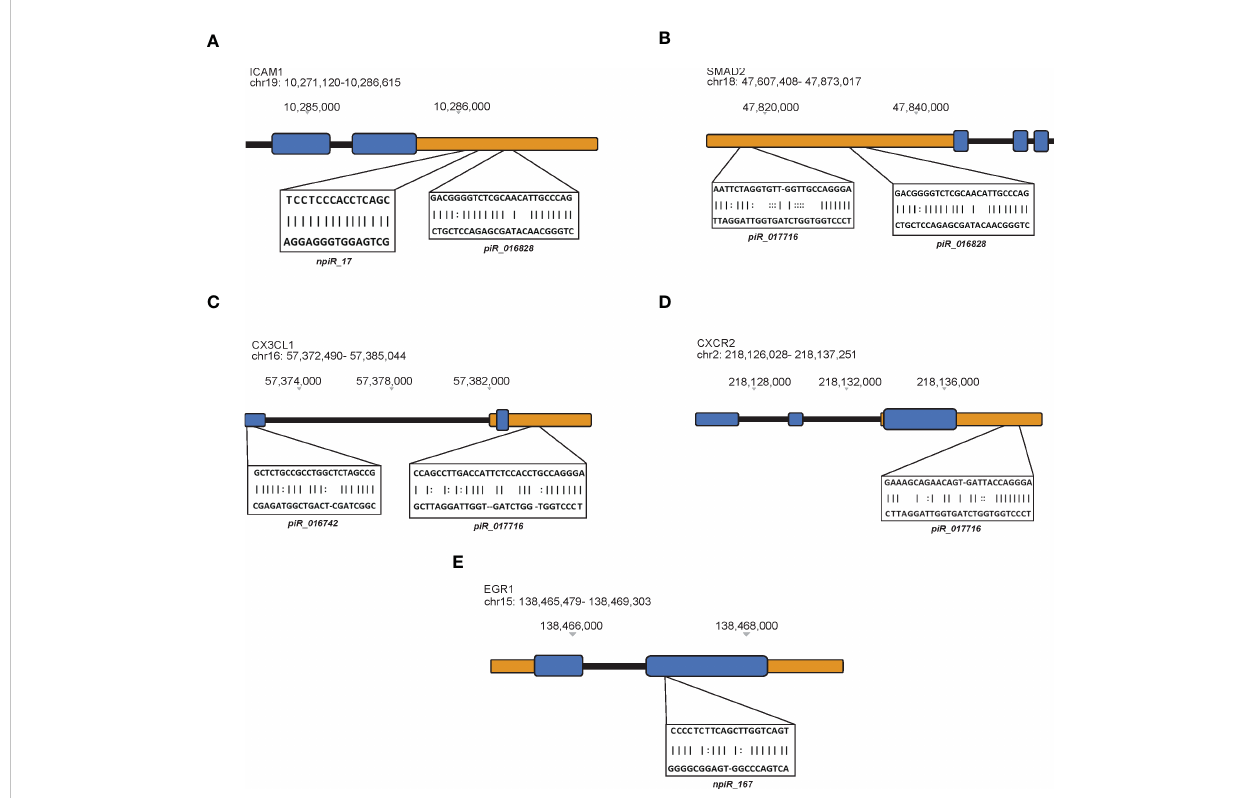
FIGURE 3 Differentially expressed piRNAs dysregulated by T. cruzi infection map to speci fi c genetic regions. The miRanda algorithm was used to predict potential target binding sites of both known and putative piRNAs. In these cartoons, exons represented by blue blocks, 5 ’ and 3 ’ untranslated regions (UTRs) are orange, and intronic regions are black. piRNAs predicted to target (A) ICAM1, (B) SMAD2, (C) CX3CL1, (D) CXCR2, and (E)